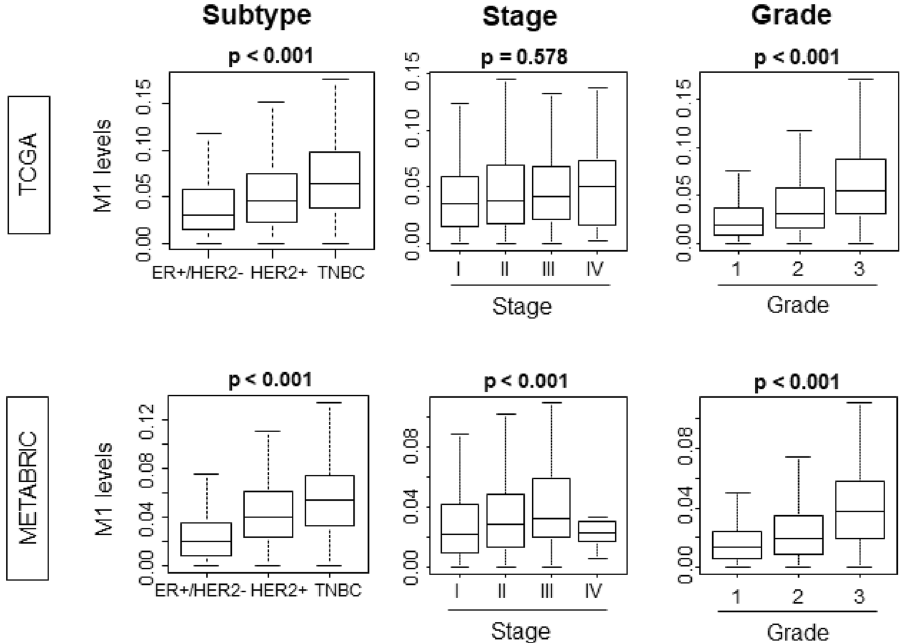
Figure 3. The expression levels of “M1” was different between the subtypes and higher number of infiltrating “M1” was associated with more advanced grade. TNBC, triple negative breast